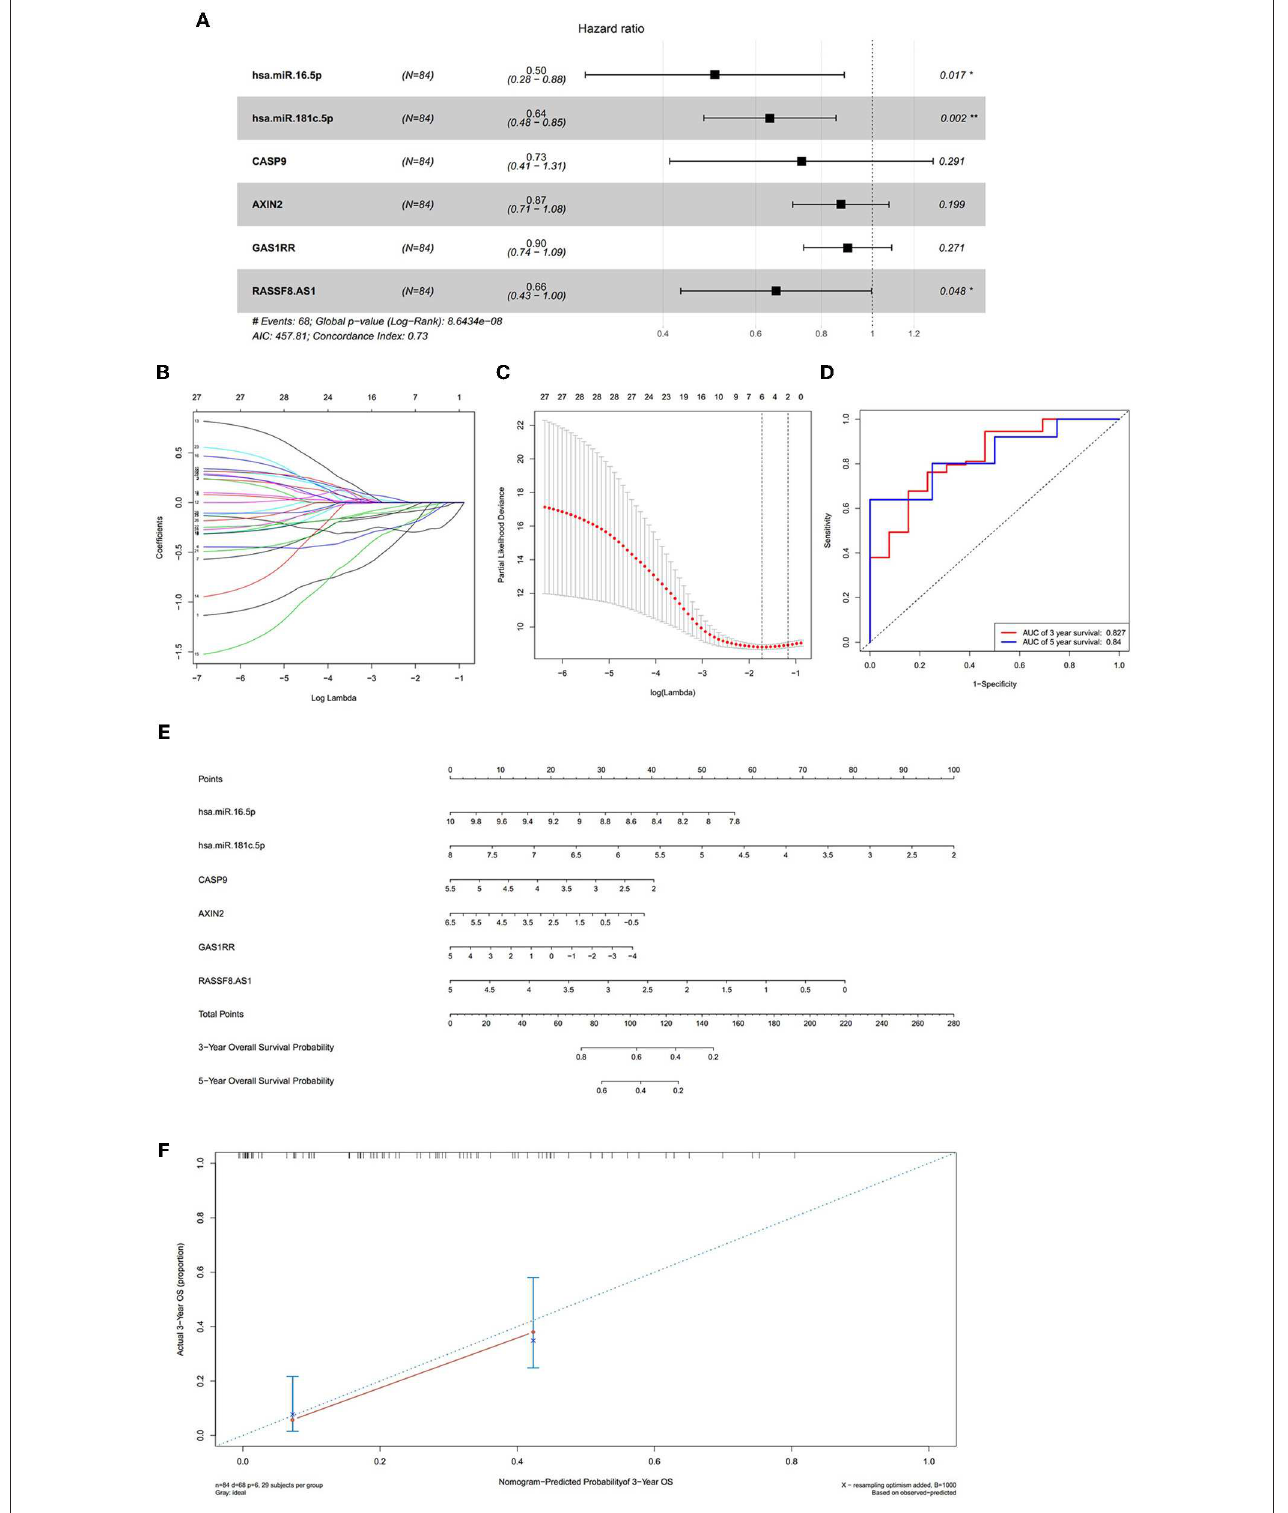
FIGURE 4 | The results of the multivariate Cox regression (A) , the results of the Lasso regression (B,C) ; the ROC curves (D) ; the nomogram (E) ; the discrimination of nomogram (F) . The results of the Lasso regression (B,C) suggested that all six genes were essential for modeling. The nomogram (E) was constructed based on the model. The ROC and the calibration (D,F) indicated the acceptable accuracy [Area Under Curve (AUC) of 3-year survival: 0.827; AUC of 5-year survival: 0.84] and discrimination of the nomogram.